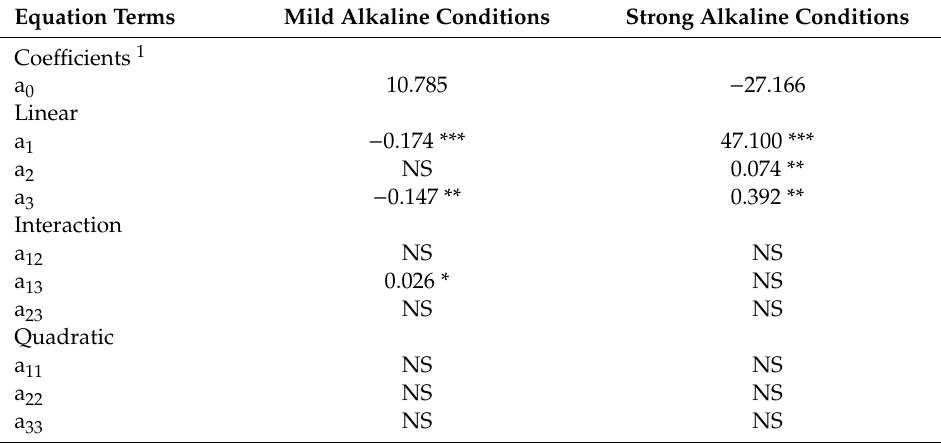
Figure 3. Pareto charts indicating the weight of each factor on the protein recovery and corresponding main e ff ects plots using ( a1 and a2 , respectively) mild and ( b1 and b2 , respectively) strong alkaline conditions. The surface plots are represented take into account the significant factors: ( a3 ) mild and ( b3 ) strong alkaline conditions. C NaOH , NaOH concentration; T , temperature; t , extraction time. * Significant at p -value < 0.05; ** significant at p -value < 0.1. Table 3. Model equation coe ffi cients and optimum conditions values for the recovery of proteins from olive mill leaves obtained using mild and strong alkaline